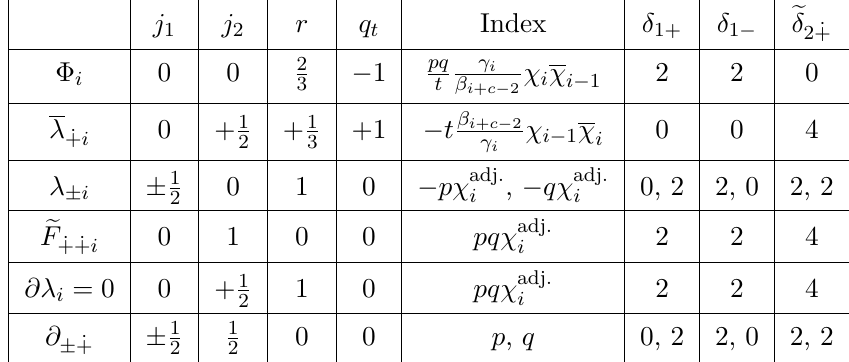
( z ) , χ ( z ) and χ adj. ≡ χ i i (1 , 0 ,..., 0) (0 , 0 ,..., 1) i